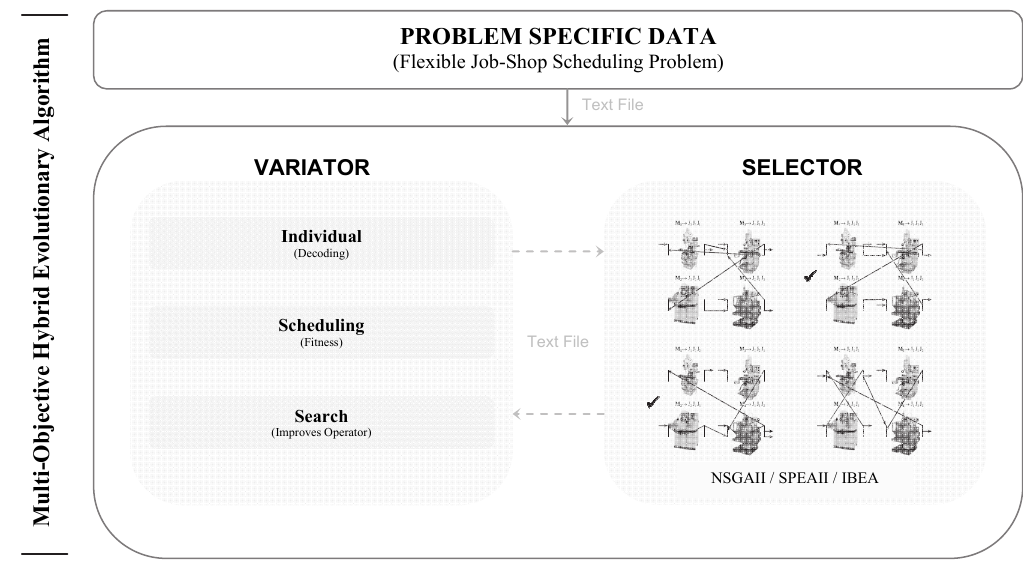
Fig. 2. Hybrid Structure in